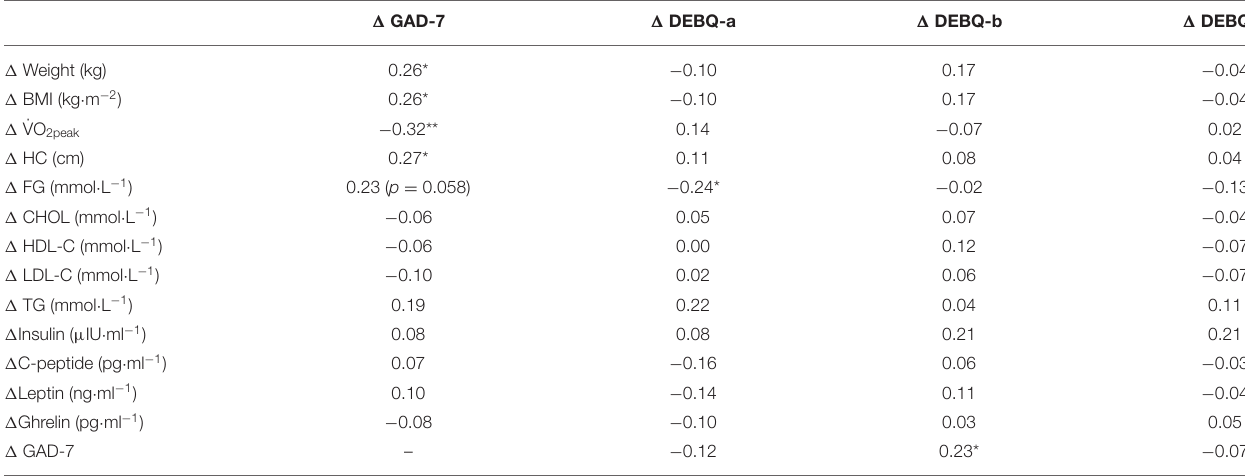
TABLE 5 | Relationships between physiological and psychological